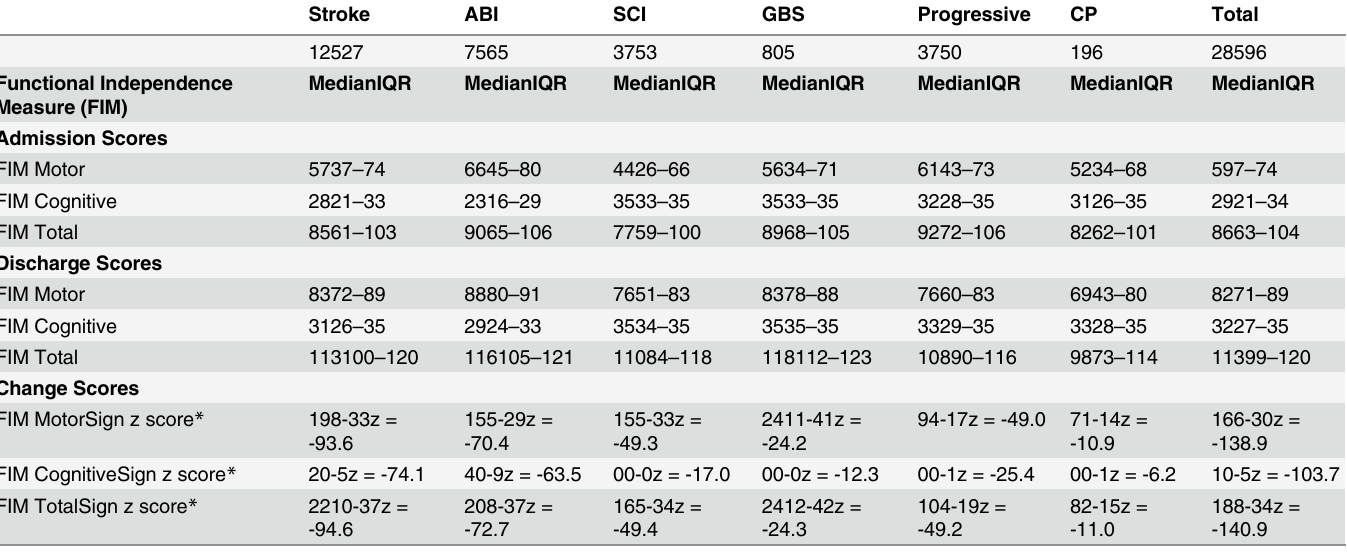
Table 5. Median (IQR) FIM total and subscale scores on admission and discharge, with Wilcoxon Signed Rank tests for change between admission and